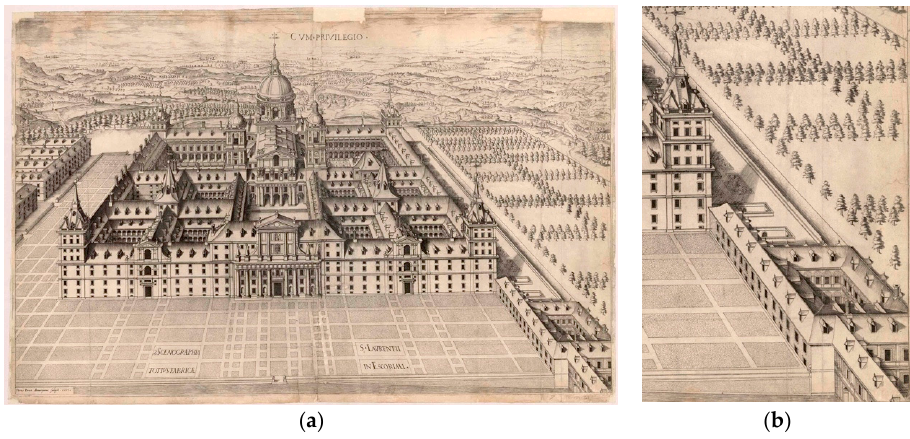
Figure 8. Juan de Herrera and Pedro Perret, 1587: Séptimo Diseño. Scenographia S. Laurentii Totius Fabricae in Escuriali. ( a ) Perspective of the Monastery from the west, showing the main entrance and the west Lonja at the foreground. ( b ) Detail of the Torre de la Enfermería, the gardens, and the building of the Botica surrounding a small patio. The arcade that links the Botica with the Compaña is also depicted. Real Biblioteca, Palacio Real de Madrid, Bookmark IX-M-243(7). Biblioteca Nacional de España, Madrid, Bookmark INVENT/28857. Just as when we talked of the Sexto diseño , the differences between the drawing and the finished building are evident. They can be clearly noticed with respect to the pitched roof, but also at the interior east and south walls of the patio, which were built almost entirely blind (Figure 9).